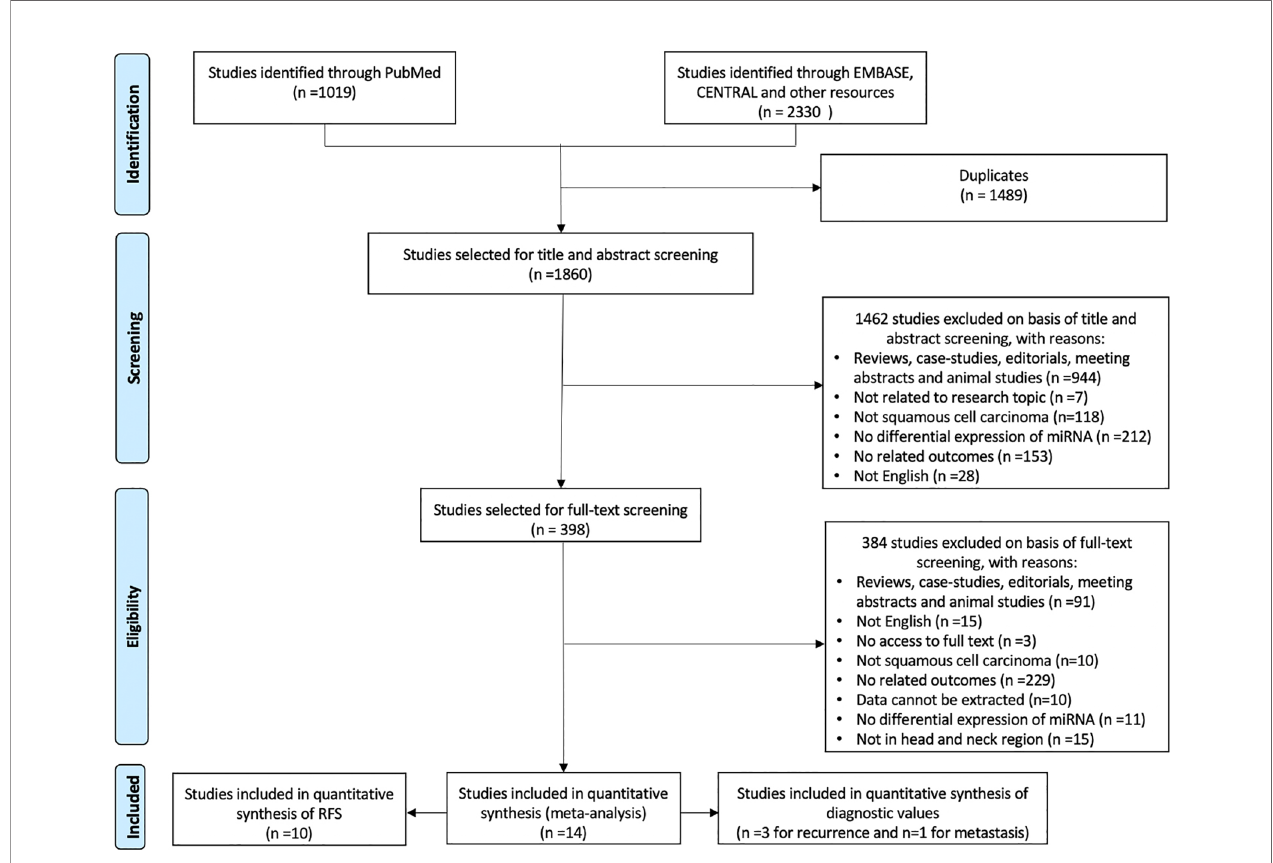
FIGURE 1 | Flow diagram summarizing the selection process of the systematic